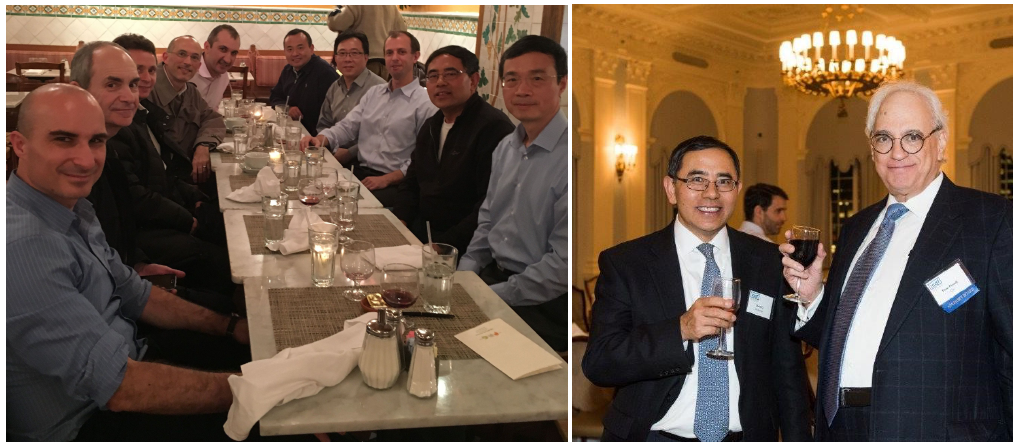
Figure 5: Left: David Li with his collegues from Barclays. Right: David Li with Evan Picoult, a colleague at Citigroup (2016).